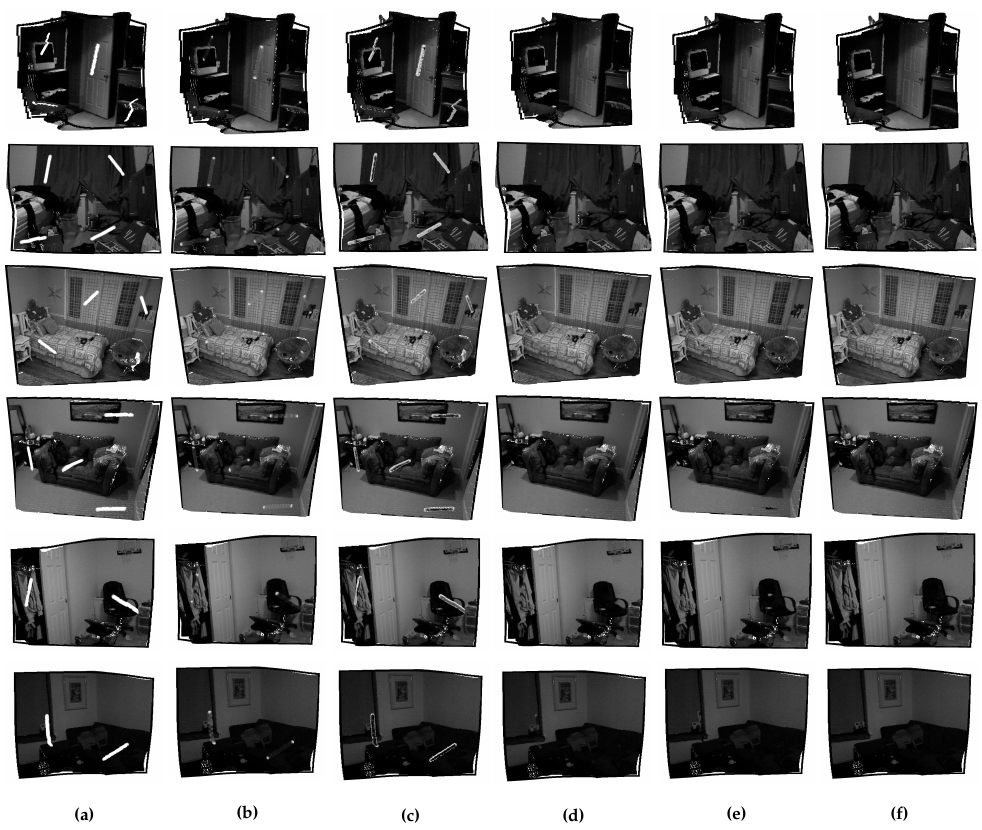
Figure 11. Effect of our simple post-processing. ( a ) The original pointcloud. ( b ) The point- cloud of FMM. ( c ) The pointcloud of BBIM. ( d ) Ours (based on FMM). ( e ) Ours (based on BBIM). ( f ) Ground